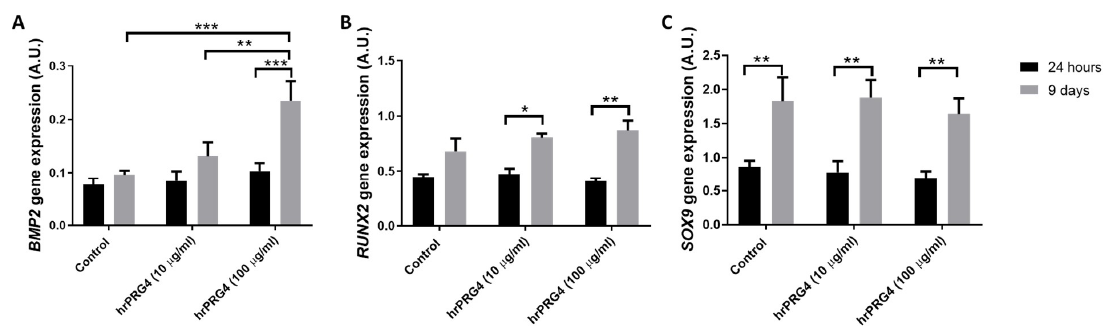
Figure 4. Effects of recombinant human proteoglycan 4 (rhPRG4) on mRNA levels of ( A ) bone morphogenetic protein 2 (BMP2), ( B ) runt‐related transcription factor 2 (RUNX2), and ( C ) SRY‐Box transcription factor 9 (SOX9) gene expression after 24‐h and 9‐day culture (N = 3–4): Statistical significance was determined using a 2‐way ANOVA repeated measurements followed by a Holm–Sidak post hoc multiple comparisons analysis; * p < 0.05, ** p < 0.01, and *** p < 0.001.